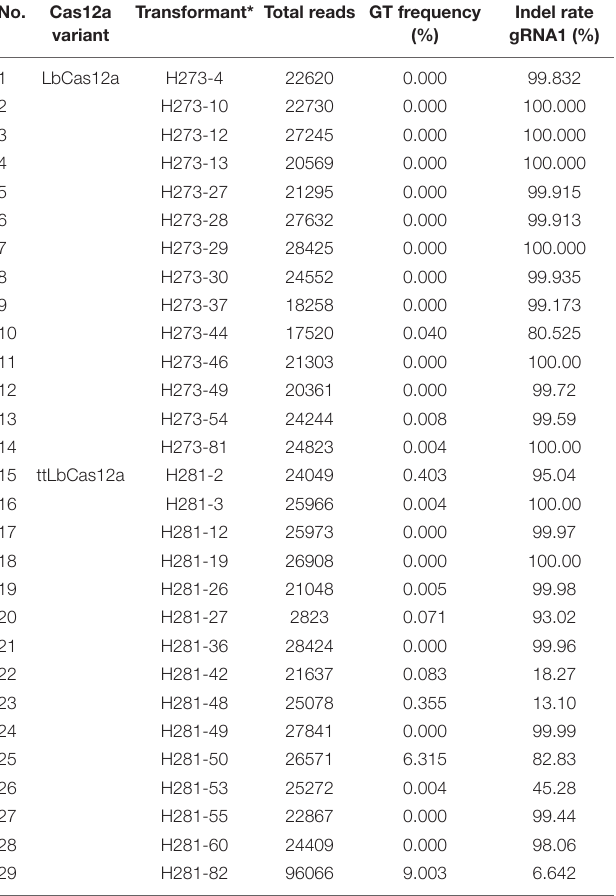
TABLE 1 | GT efficiency revealed from transformants by targeted deep